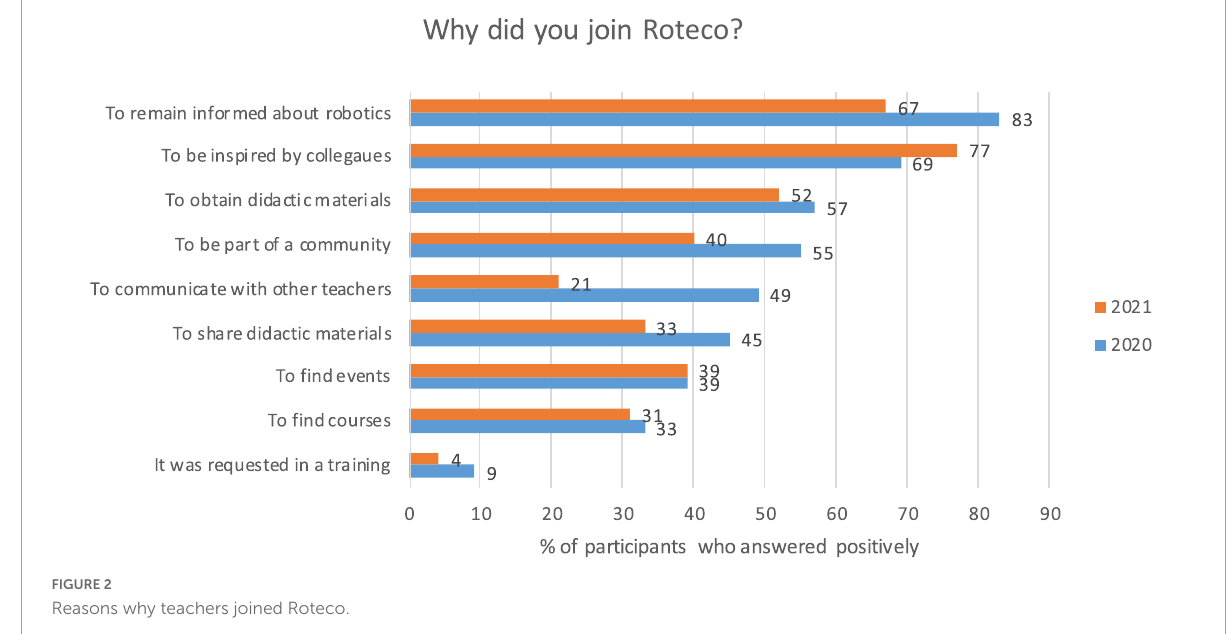
FIGURE2 Reasons why teachers joined